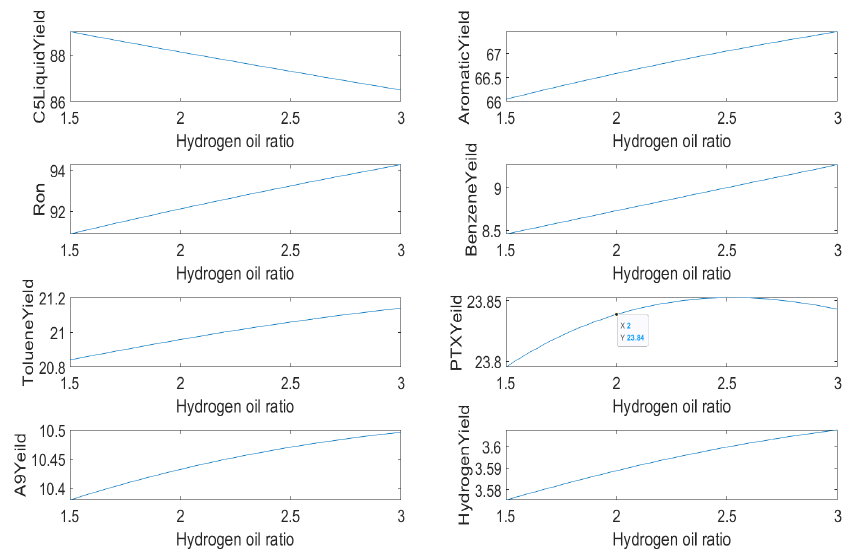
Figure 10. The influence of hydrogen–oil ratio on the yield of each